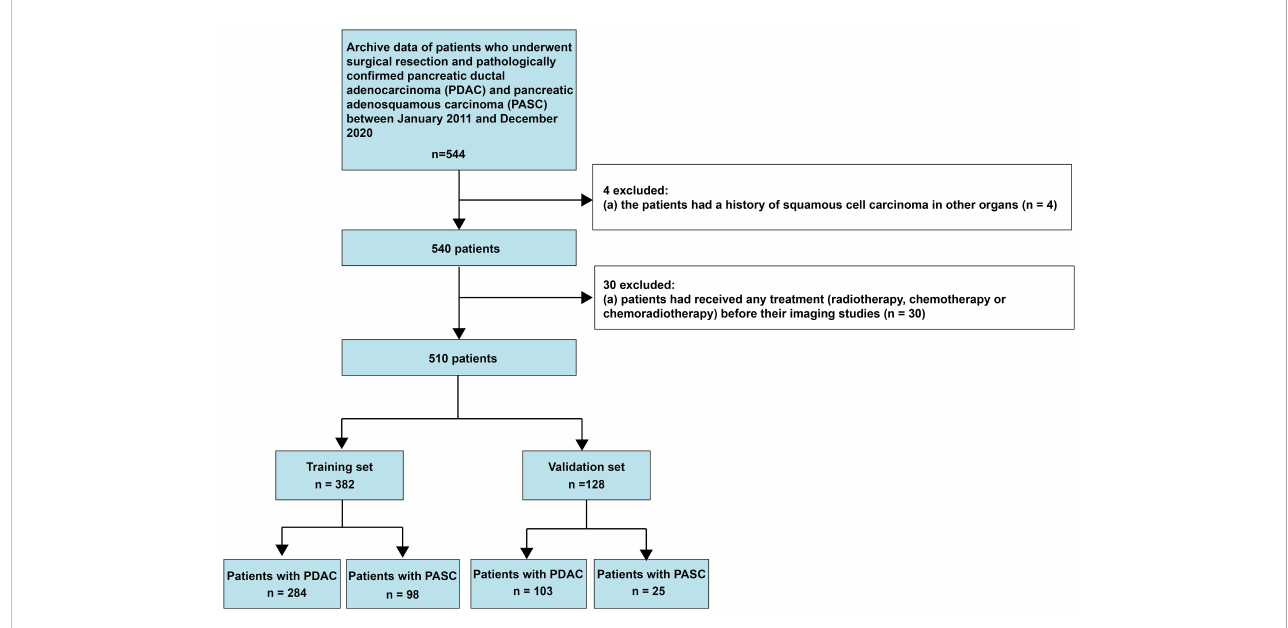
FIGURE 1 Flow chart illustrating patient selection